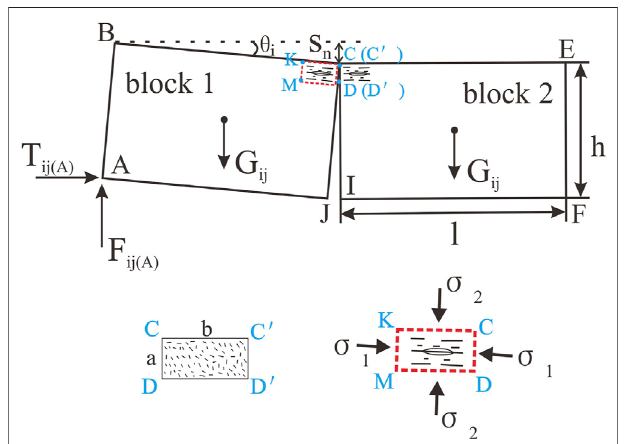
FIGURE 3 | Three-hinged arch structure and damage area of contact surface (Note: Rectangle CC´DD ’ is the contact surface of compression damage between rock blocks, and the rectangle CDKM is the magni fi ed display of the tensile fractures caused by the compression during the crushingoftherockblocks, σ 1 , σ 2 , σ 3 arethe1st,2nd,and3rdprincipalstress inthecontactarea,respectively,andtheirdirectionsarethedirectionofmutual extrusion between the two rock blocks, Parallel to the direction of the longitudinal section between the blocks and parallel to the direction of the cross section of the stope.).